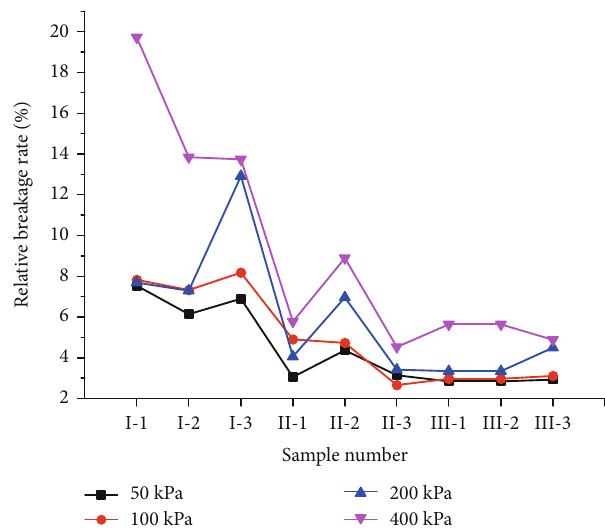
Figure 13: Relative breakage rate of each